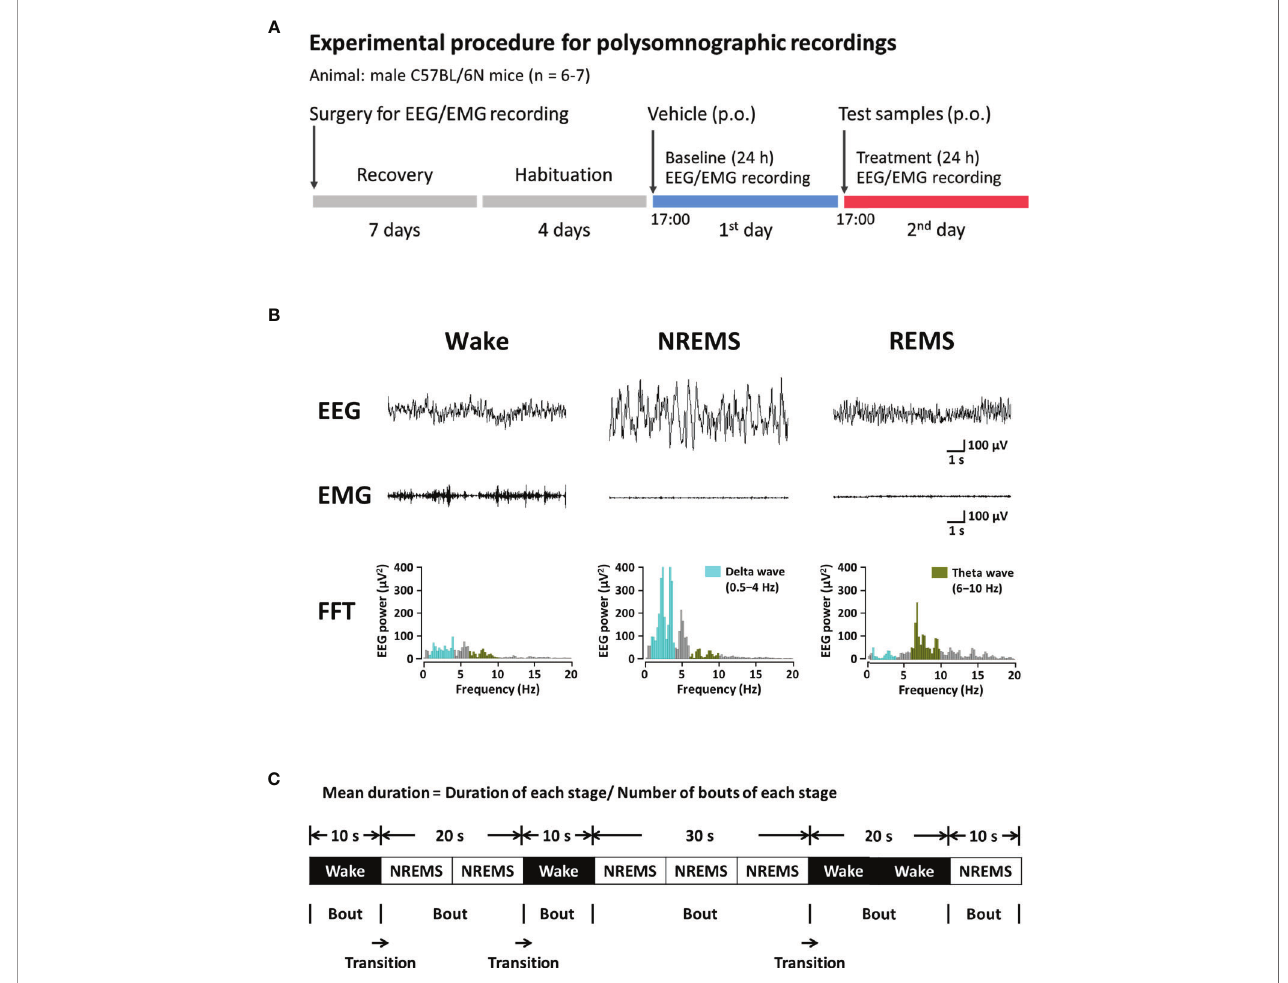
FIGURE 2 | Experimental procedure (A) , typical EEG, EMG, and FFT spectra (B) , and de fi nition of sleep-wake episodes (C) in C57BL/6N mice. EEG, electroencephalogram; EMG, electromyogram; FFT, fast Fourier transform; NREMS, non-rapid eye movement sleep; REMS, rapid eye movement sleep; Wake,